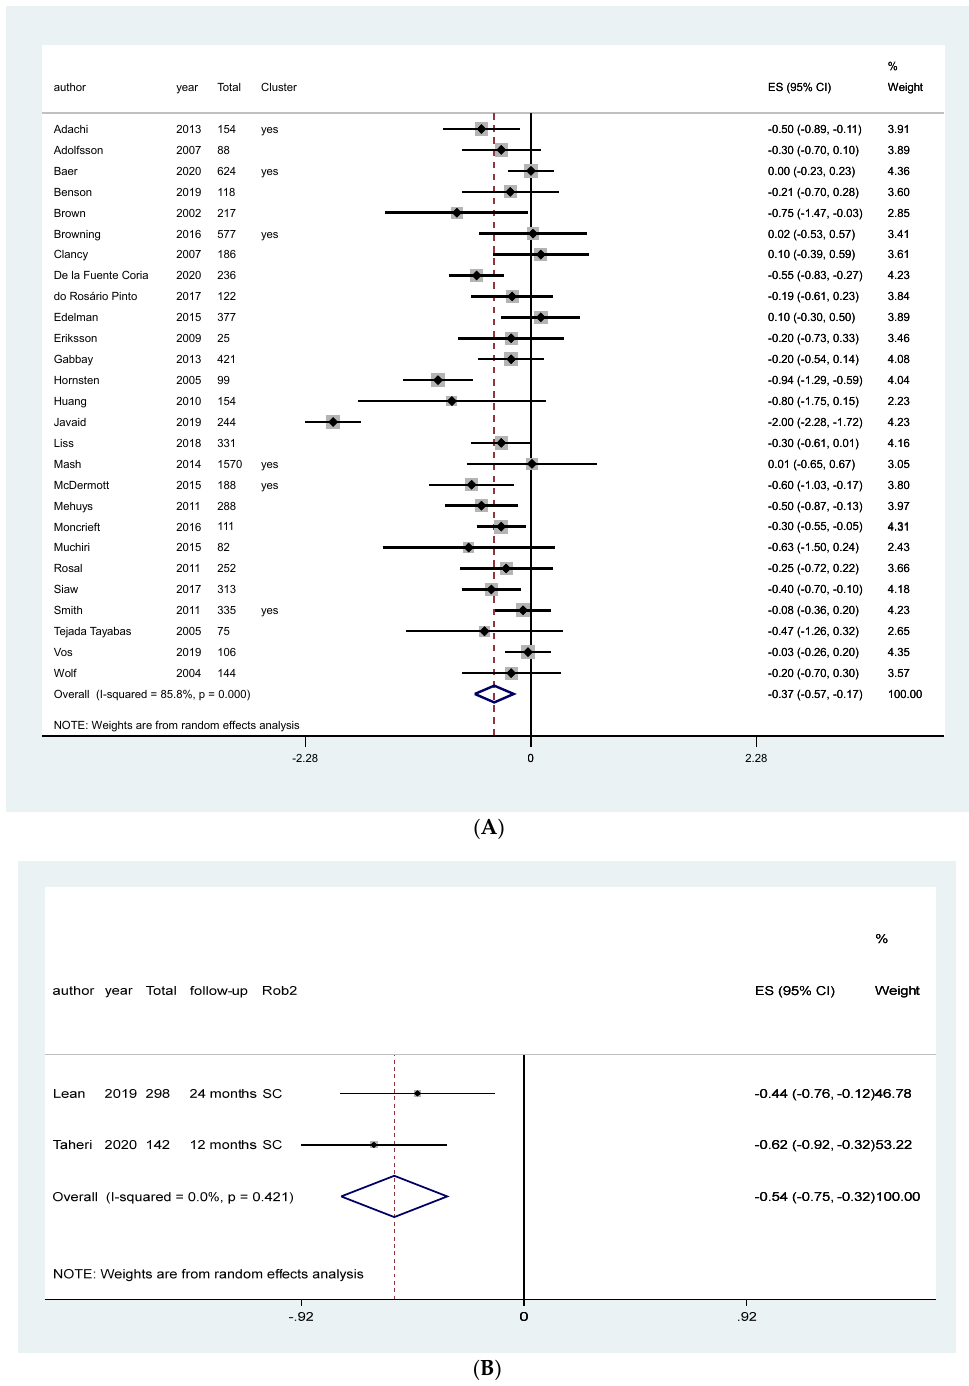
Figure 4. Meta-analysis of the effect of NT on HbA1C in patients primarily diagnosed with type 2 Diabetes Mellitus according to the type of intervention. ( A ) Counseling and educational programs, ( B ) Food replacement.